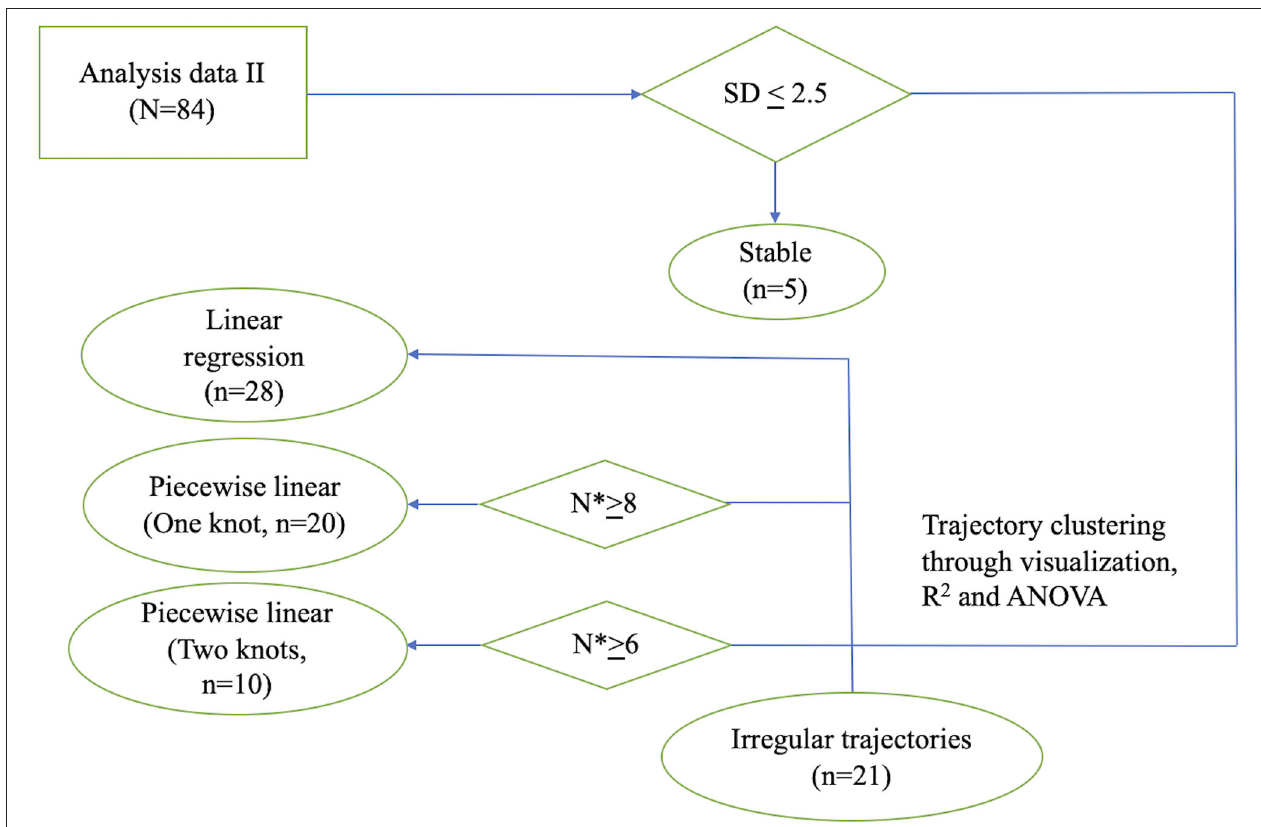
FIGURE 2 | Flowchart illustrating the process of individual model fitting. Flowchart illustrating the process of individual model fitting for the 84 PD patients ( n : number of patients; N *: number of observations per patient). SD, standard deviation; ANOVA, analysis of